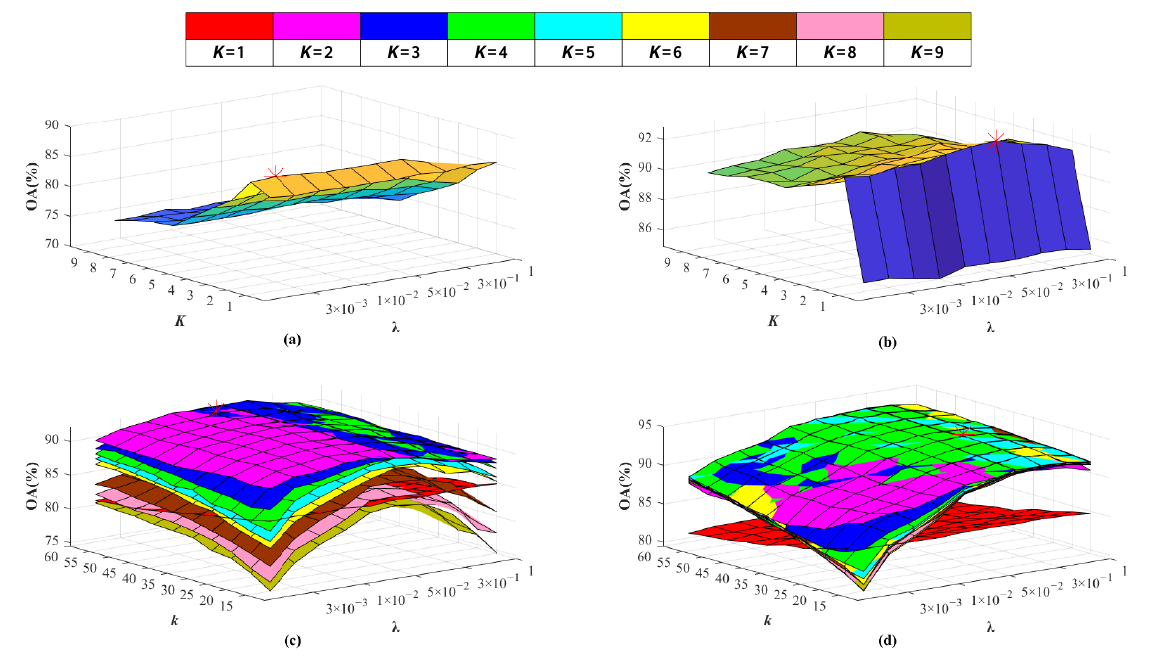
Figure 3. Classification performance for ( a ) KNCCRC, ( b ) KNCCRT, ( c ) LNNCRC, and ( d ) LNNCRT under different parameters. Table 2. Optimal parameter settings for each method.